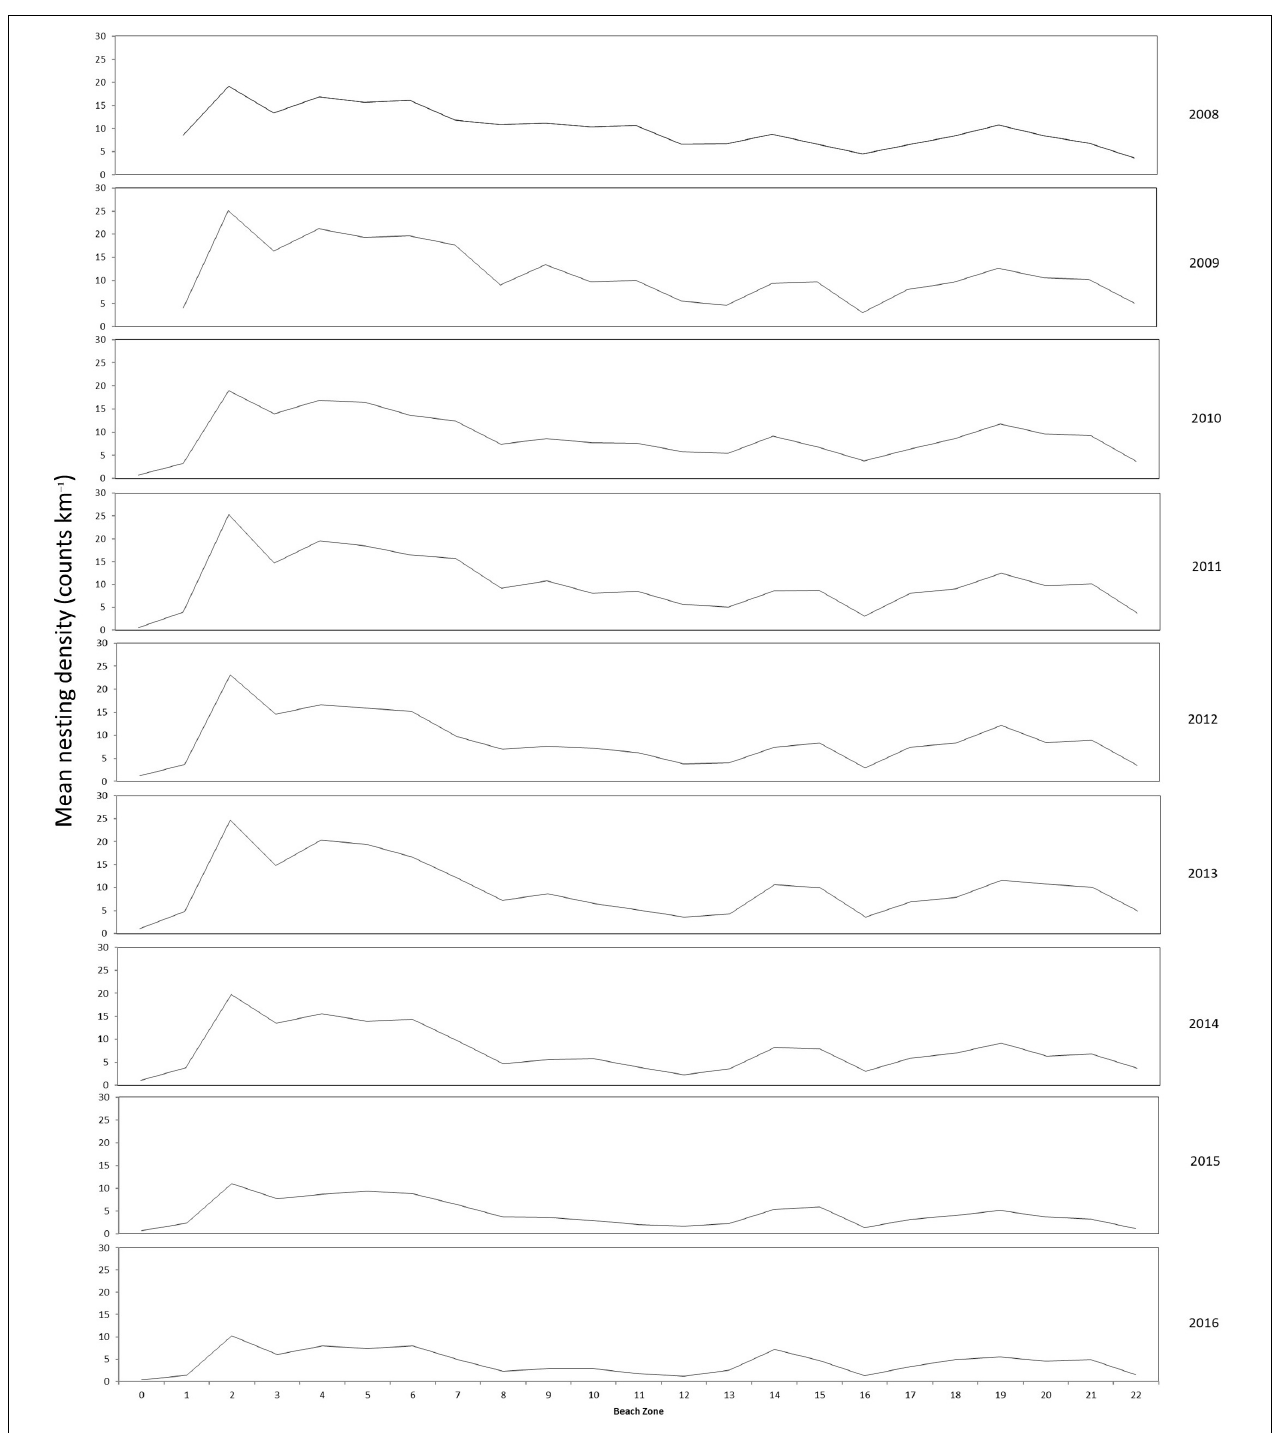
FIGURE 6 | Longshore distribution of annual mean nesting density of index beaches (K0–K22) for marked beach sections surveyed between 2008 and 2016.